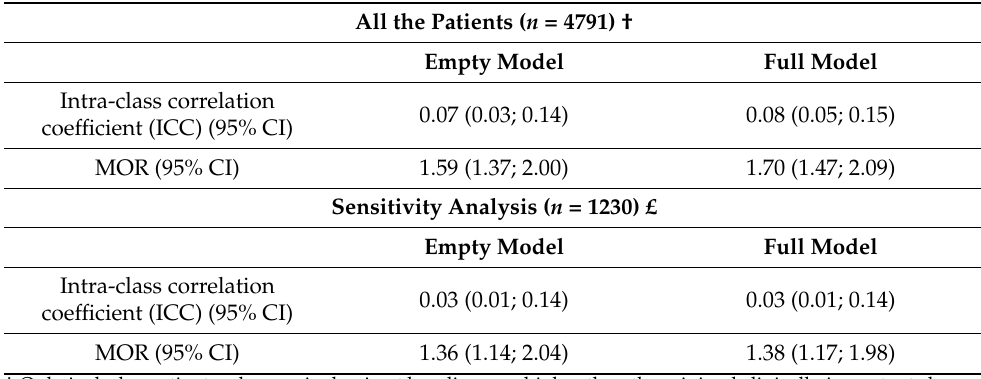
Table 3. Estimates of the inter-physician variability for improvement in spinal pain (SP).